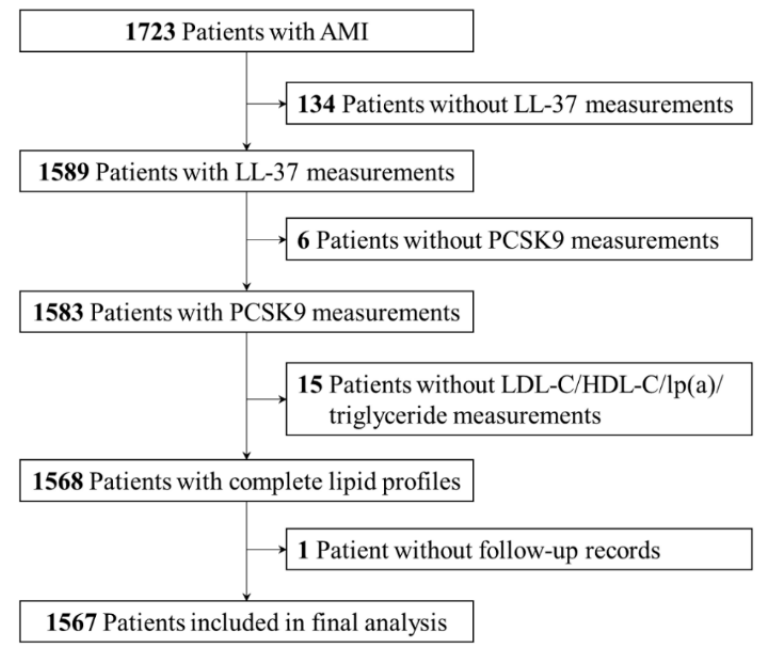
Figure 1. Study flow chart. AMI = acute myocardial infarction; HDL-C = high-density lipoprotein cholesterol; LDL-C = low-density lipoprotein cholesterol; lp(a) = lipoprotein(a); PCSK9 = proprotein convertase subtilisin/kexin type